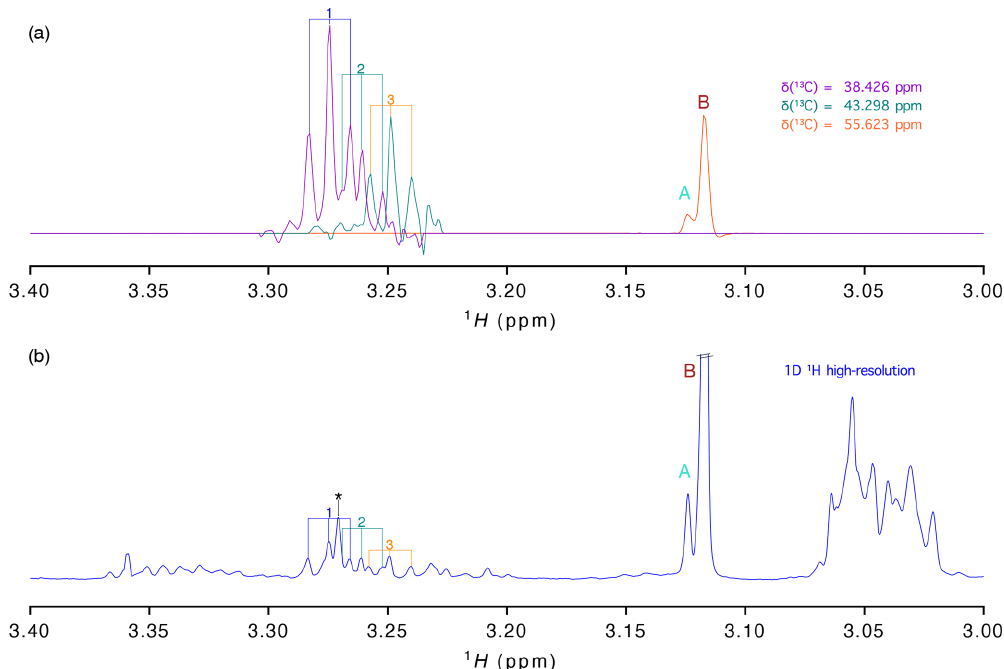
Figure 3. (a) 1 H traces extracted from the virtually decoupling at different 13 C chemical shifts and (b) 1-D 1 H spectrum with high resolution (acquired with 16384 points). Signals are labelled as in Fig.